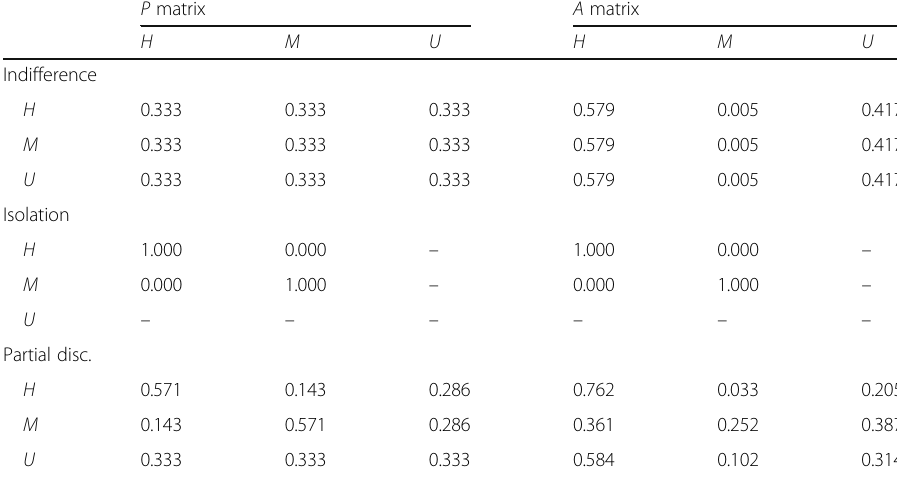
Table 1 Examples of P and A matrices for three alternative preference patterns: one-time immigration P matrix A